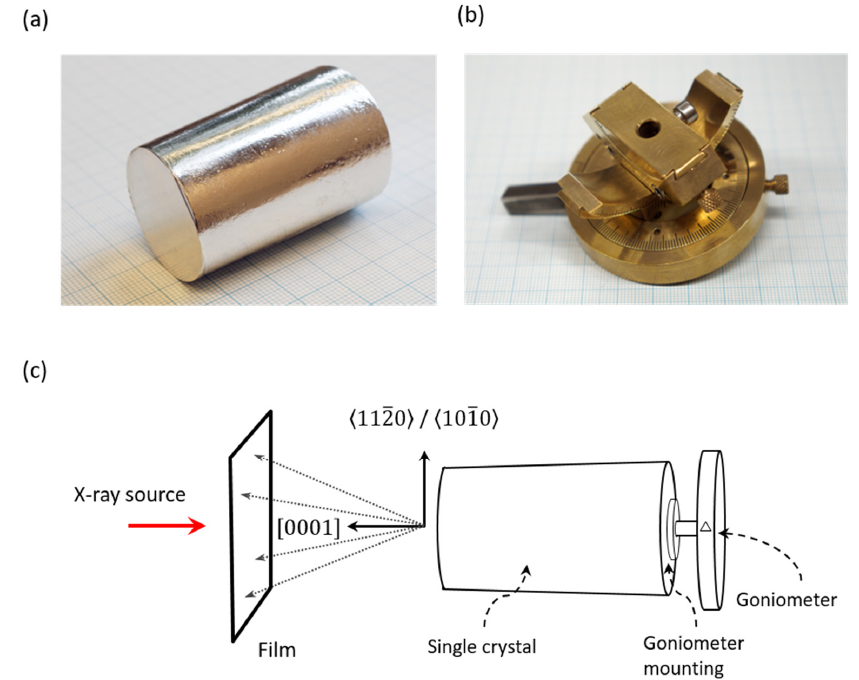
Figure 1. ( a ) Conically shaped pure Mg single crystal (etched in dilute nitric acid) with the c -axis nearly parallel to the axis of symmetry (millimeter paper for scale); ( b ) 3-axis goniometer used for alignment of the single crystals and ( c ) schematic illustration of a single crystal mounted on a goniometer and aligned according to the desired orientation of the final specimens using Laue (white beam) X ‐ ray backsca tt er di ff raction.